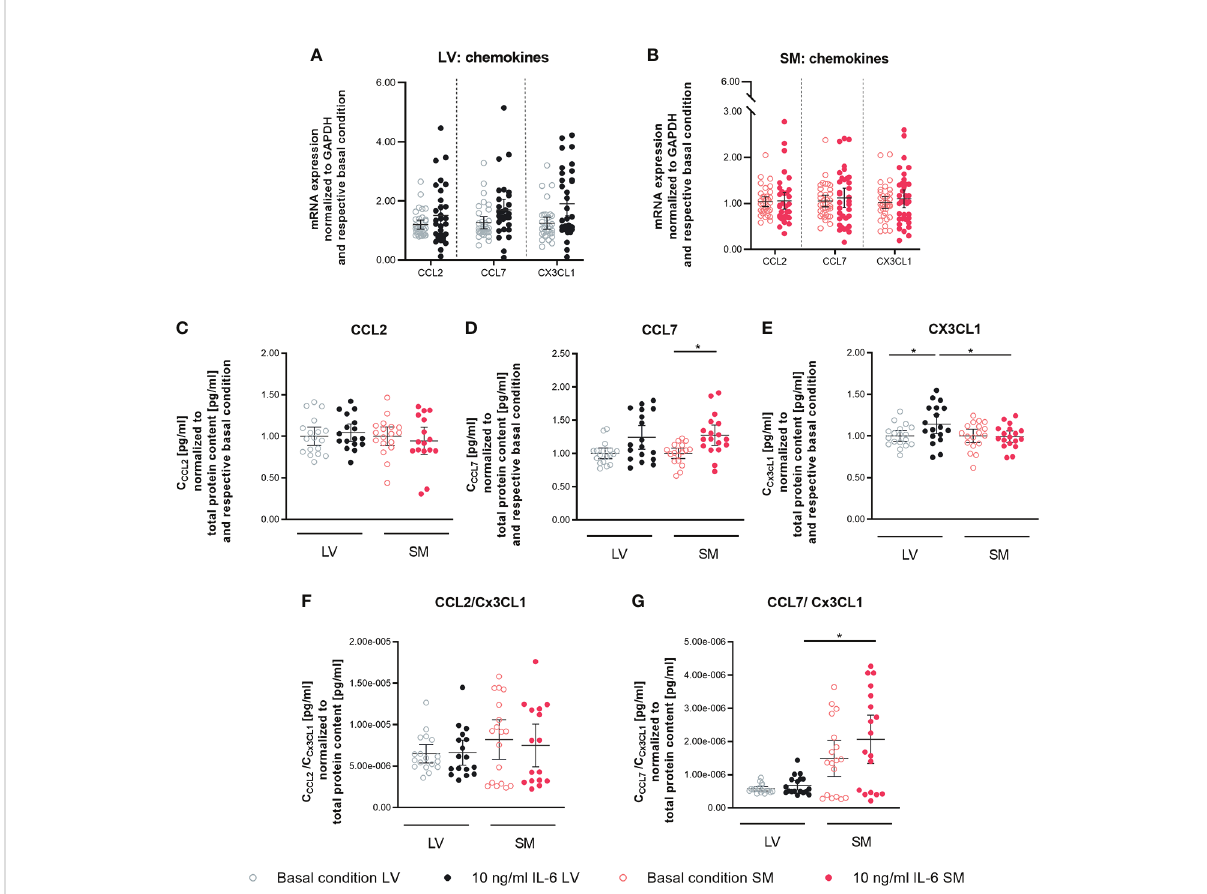
FIGURE 3 IL-6 stimulation leads to secretion of anti- and pro-in fl ammatory chemokines in left ventricle- and skeletal muscle-derived fi broblasts. mRNA expression of CCL2, CCL7 and CX3CL1 normalized to GAPDH and the respective basal condition of (A) LV-(black) and (B) SM- (red) derived fi broblasts after 24 h culture with basal medium without IL-6 (basal condition; hollow circle) or with10 ng/ml IL-6 ( fi lled circle); n=36, N=6, Mann-Whitney/Welch ’ s test; Protein expression of (C) CCL2, (D) CCL7 and (E) CX3CL1 in the supernatant and ratio of (F) CCL2 and CX3CL1 and (G) CCL7 and CX3CL1 normalized to total protein content measured via bicinchoninic acid assay and respective basal condition of LV (black)- and SM (red)-derived fi broblasts after 72 h culture with basal medium without IL-6 (basal condition; bright hollow circle) or with 10 ng/ml IL-6 (dark fi lled circle); n=24, N=4, Kruskal-Wallis/One-Way ANOVA; All data are presented as mean ± 95 % CI and tested with post hoc Benjamini- Hochberg correction; adjusted p-values: *p <